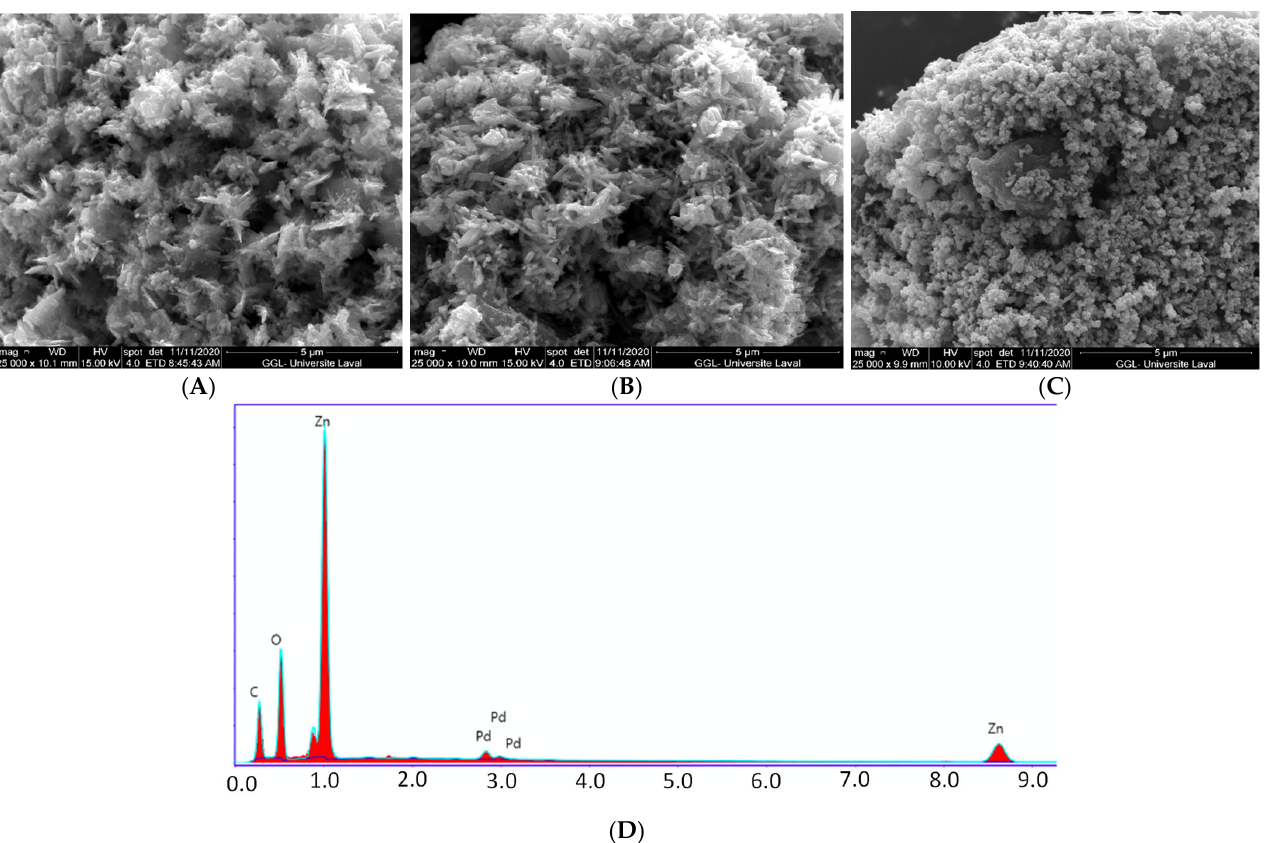
Figure 1. SEM images for ( A ) ZnO; ( B ) Pd-ZnO; ( C ) Pd-GO-ZnO; ( D ) EDX spectrum of the Pd-GO-ZnO-5 material.